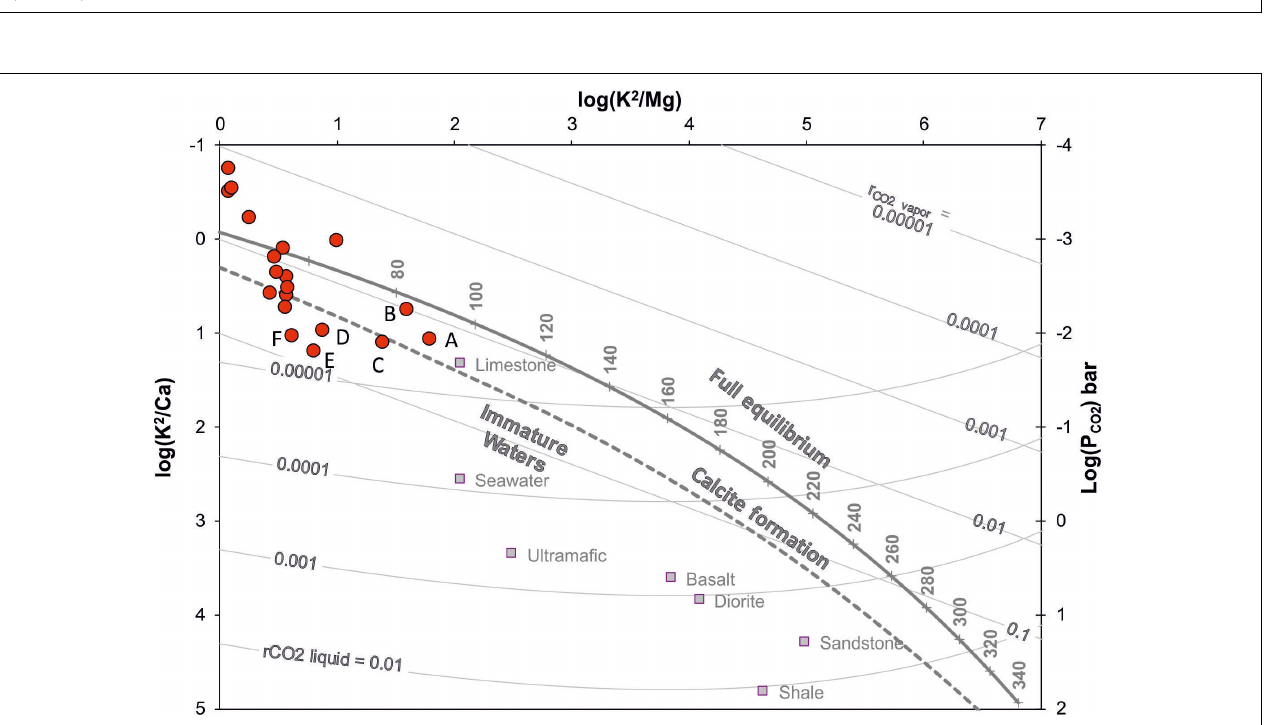
FIGURE 6 | Graph of log(K 2 /Mg) vs. log(K 2 /Ca) for some selected sites (see text for explanation). Some waters fall well within the conditions of geothermal interest, showing calculated equilibrium temperature values in the range between about 50 ◦ C and about 90 ◦ C.